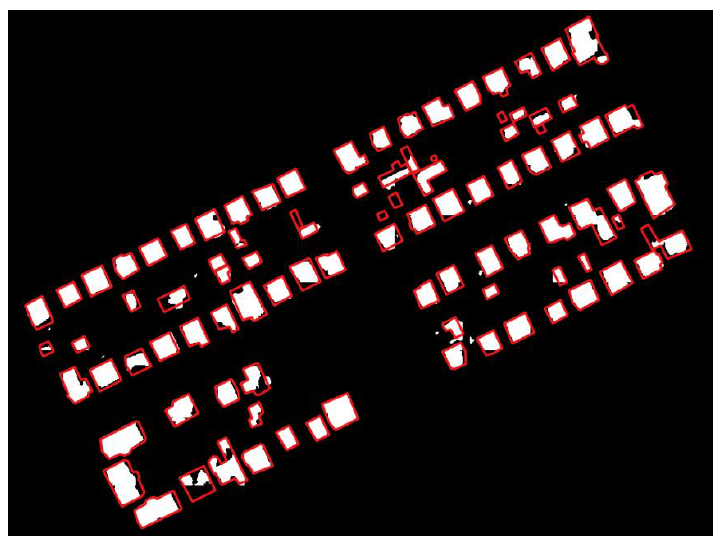
Figure 13. Ground truth cadastral data overlap with results—Subotica.